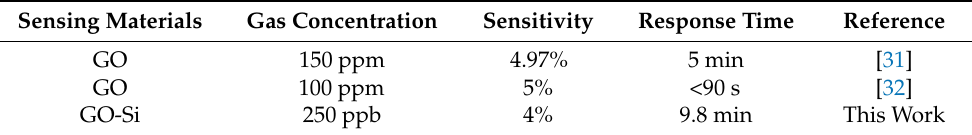
Table 2. Comparison of various indicators between different sensors based on GO. Sensing